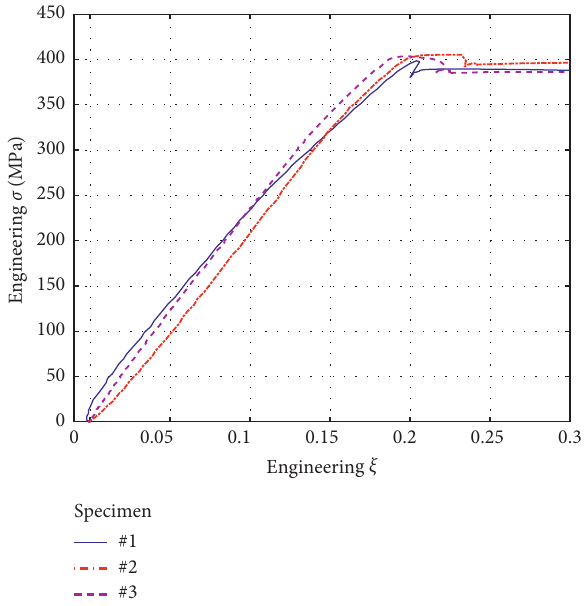
Figure 2: Measured engineering σ - ε curves for the coated carbon